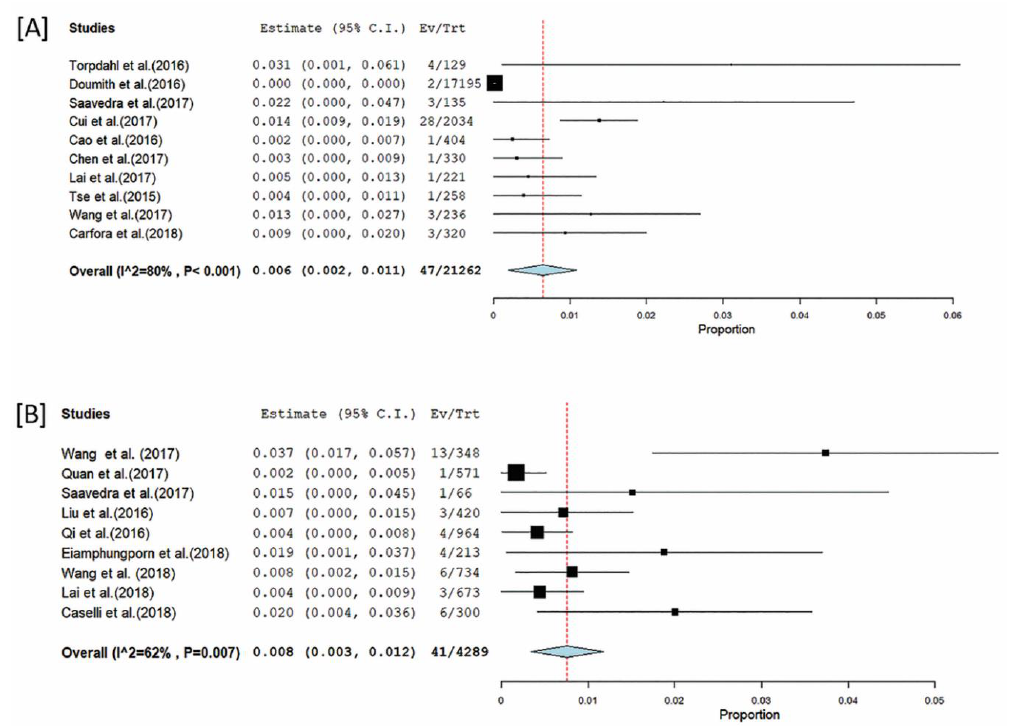
Figure 6. Prevalence of Salmonella ( A ) and Klebsiella ( B ) carrying mcr-1 . X -axis is the proportion of the bacteria reported in individual studies as listed along the Y -axis, with the range of proportion in 95% confidence interval. Studies given higher weights are indicated by larger markers. The parallelograms in yellow and the square markers in black represent the pooled point estimate for the sub-group category and individual study, respectively. The horizontal lines of the parallelograms and the square markers represent the 95% confidence interval of this combined point estimate .